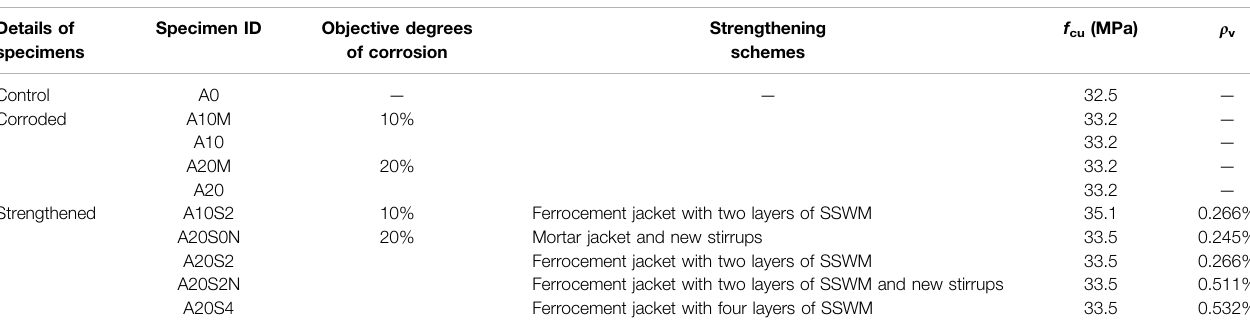
TABLE 1 | Details of column